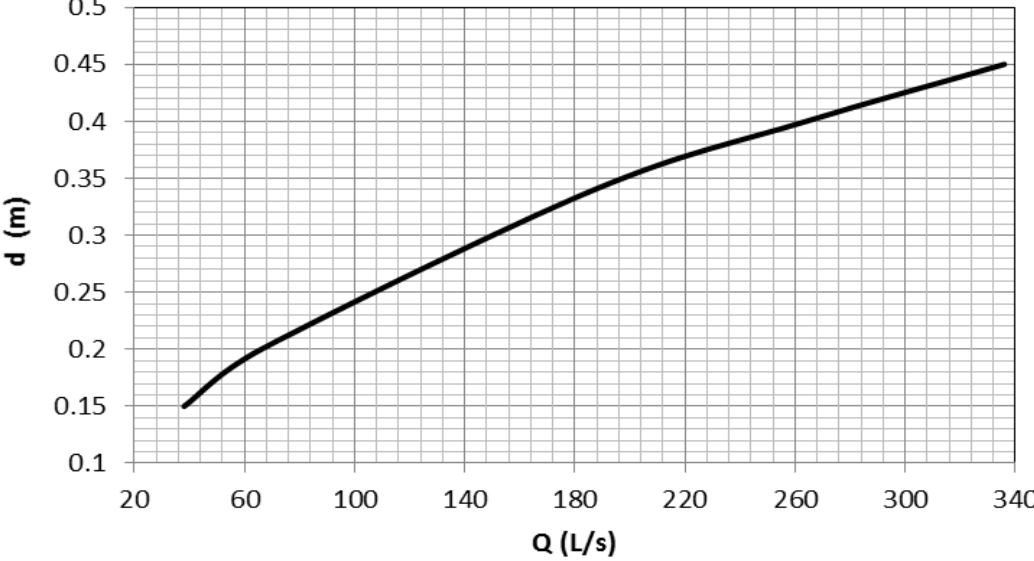
Figure 6. Discharge rating curve of the Incirli brush fish pass.